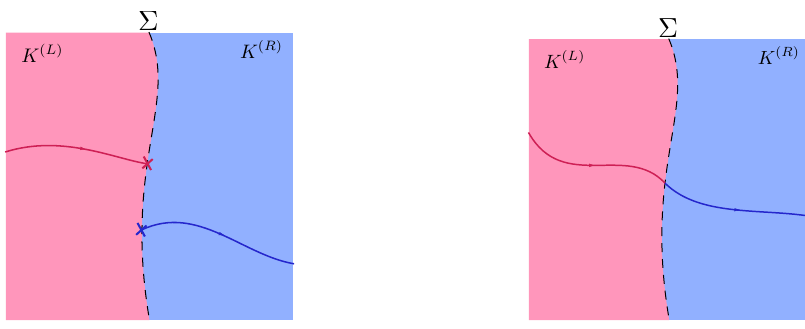
Figure 2 . (Left) Generically an interface will support global U(1) N charges (depicted here as Wilson lines ending on (cid:6). (Right) The TBCs provide an identi(cid:12)cation of the gauge group across (cid:6) and therefore describe Wilson lines that can permeate the